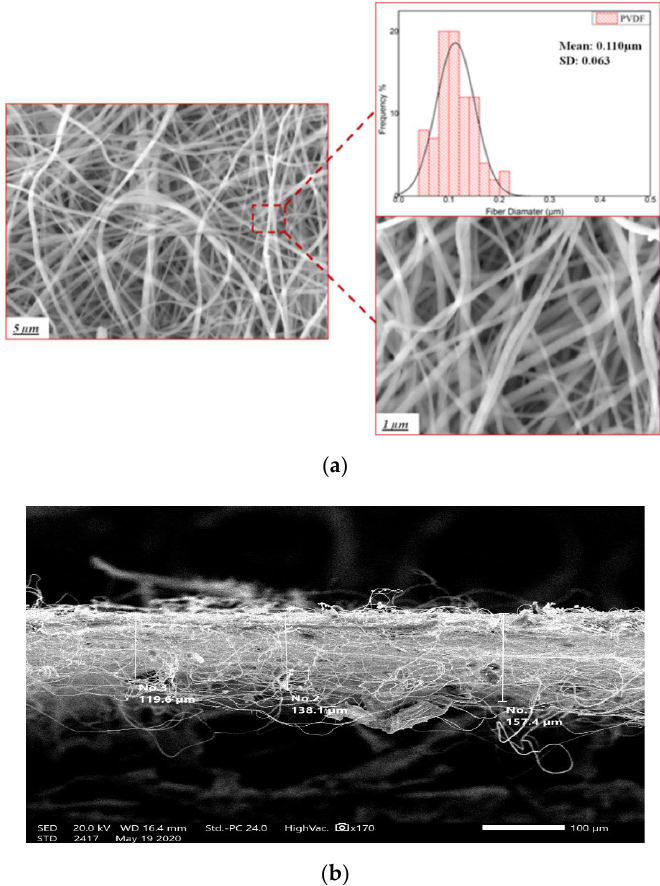
Figure 2. ( a ) SEM image with fiber diameter distribution for the electrospun poly (vinylidene fluoride) nanofiber (PVDF NF) mats, and ( b ) cross-section of the generated membrane.